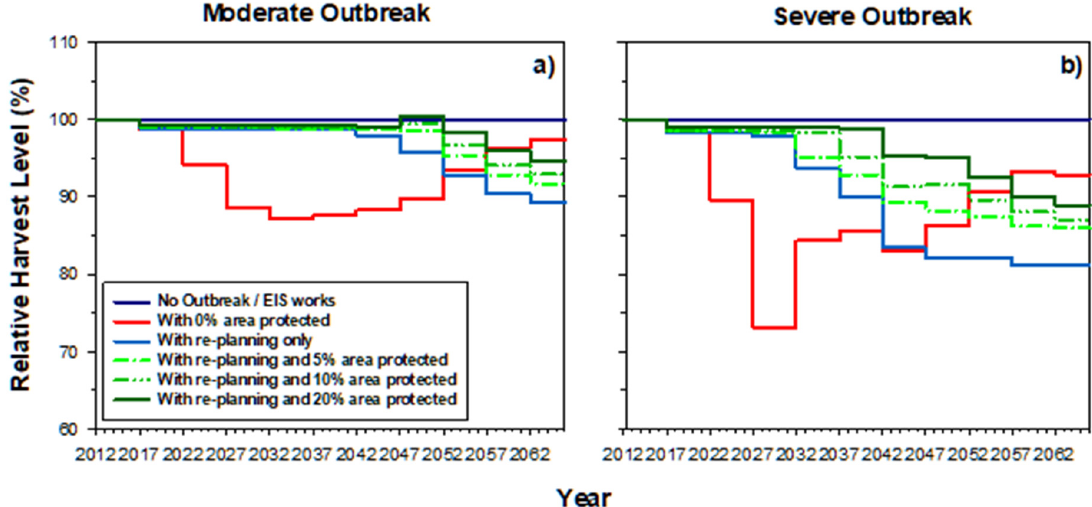
Figure 1. Projected relative total timber volume harvest for all Crown land in New Brunswick from 2012 to 2066 under ( a ) moderate and ( b ) severe spruce budworm ( Choristoneura fumiferana Clem.) (SBW) outbreak and protection scenarios.